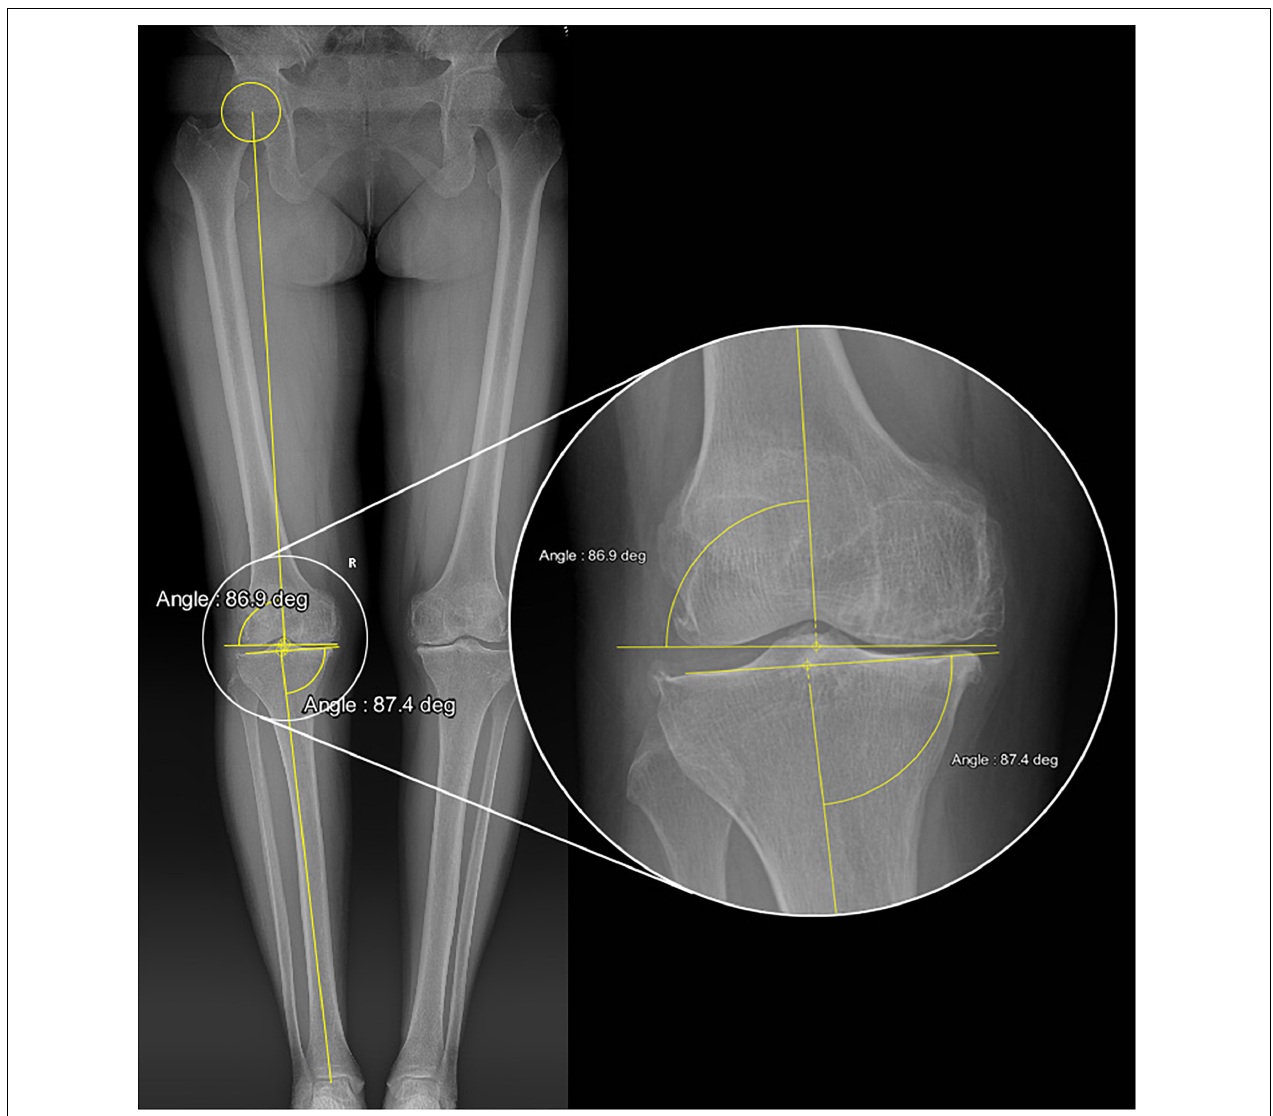
FIGURE 1 | Full-length weight-bearing radiograph of the “standard” patient showing the values of mLDFA and